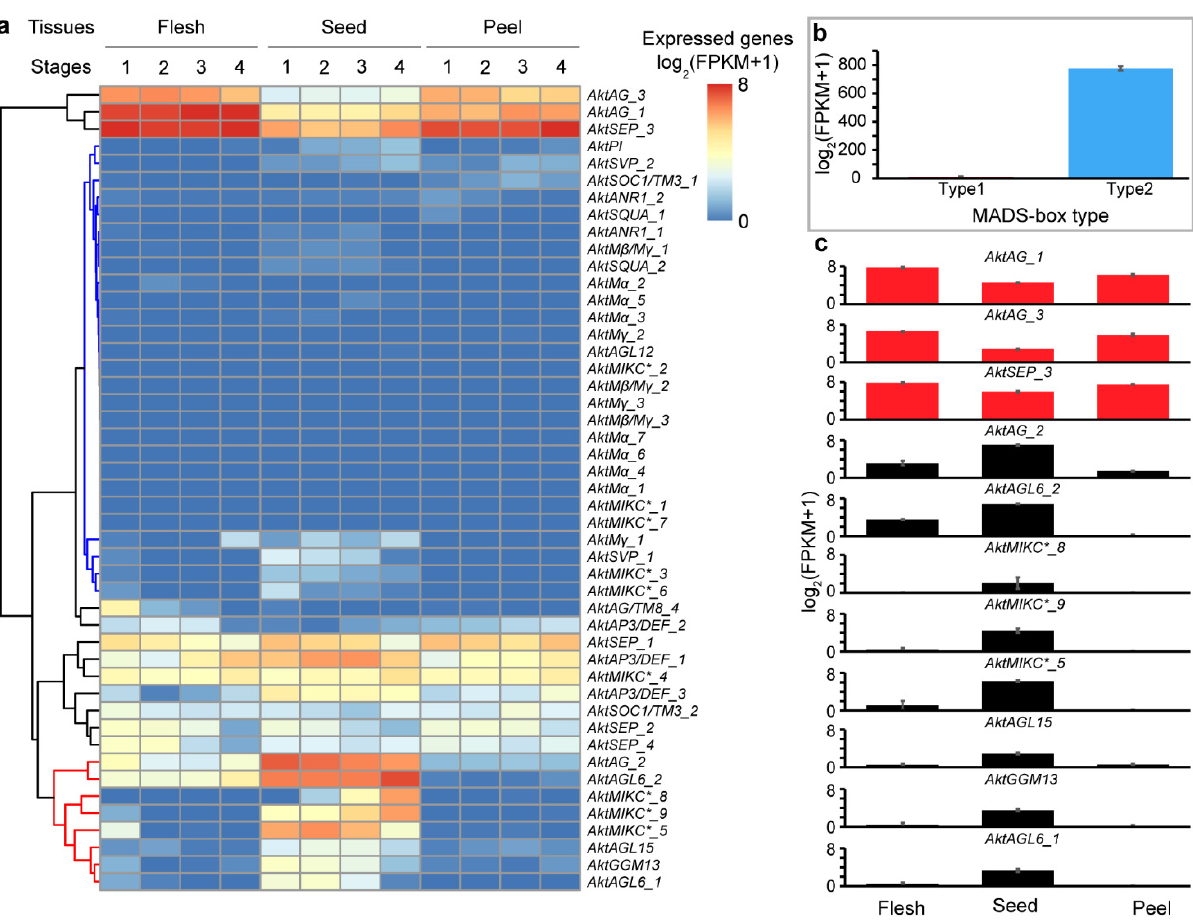
Figure 5. Expression levels of 47 MADS-box genes in different tissues and developmental stages. ( a ) Cluster results of gene expressions, FPKM represent fragments per kilobase of transcript per million fragments mapped. ( b ) Total expression levels of type I and type II genes, respectively. ( c ) Expressions of representative gene in three